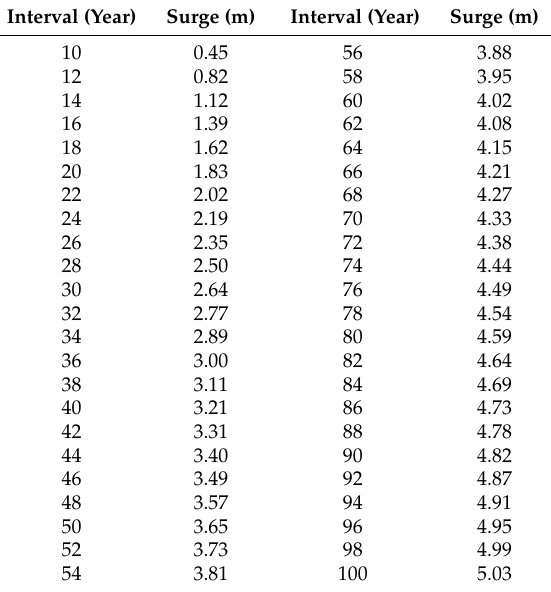
Figure A2. Storm surge recurrence intervals from the SurgeDat database and return period predictor for a 25-mile radius centered on 25.2 ◦ N, 80.7 ◦ W. Table A4. Recurrence interval projection in years from the Florida Bay SurgeDat data. Note that this projection does not take into account future sea level